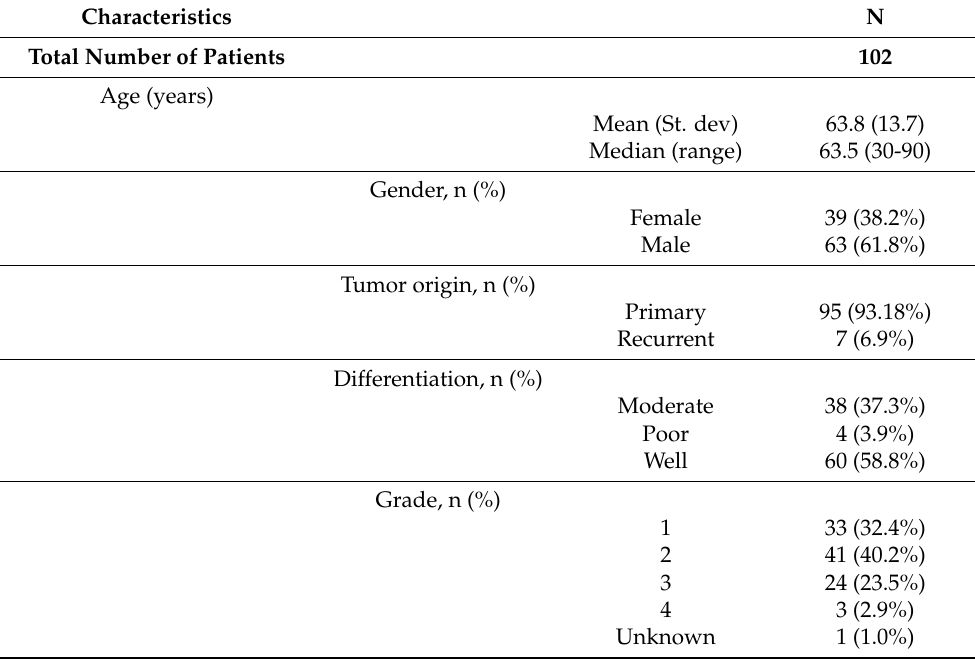
Table 1. Characteristics of patients with OSCC in this